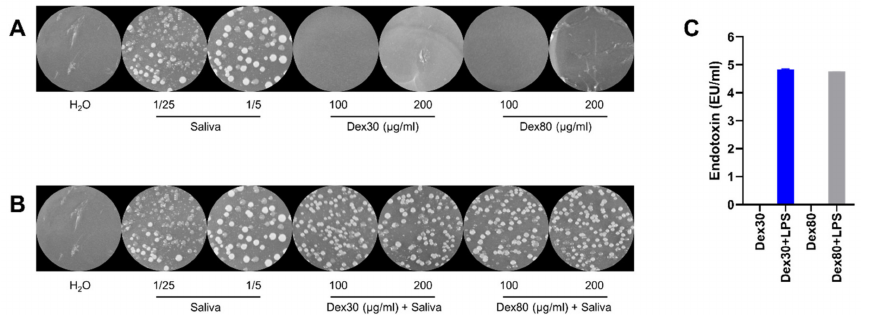
Figure 2. SPION Dex are free of bacterial and endotoxin contaminations. ( A ) Agar plates were incubated with differently sized dextran-coated SPIONs for 72 h. H 2 O was used as negative and water-diluted saliva (1:5 and 1:25) as positive controls. ( B ) SPIONs supplemented with 1:25